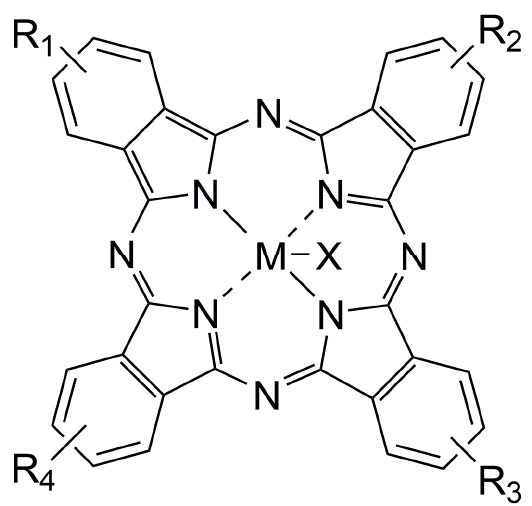
Figure 2. General chemical structure of metallated phthalocyanines (MPcs).